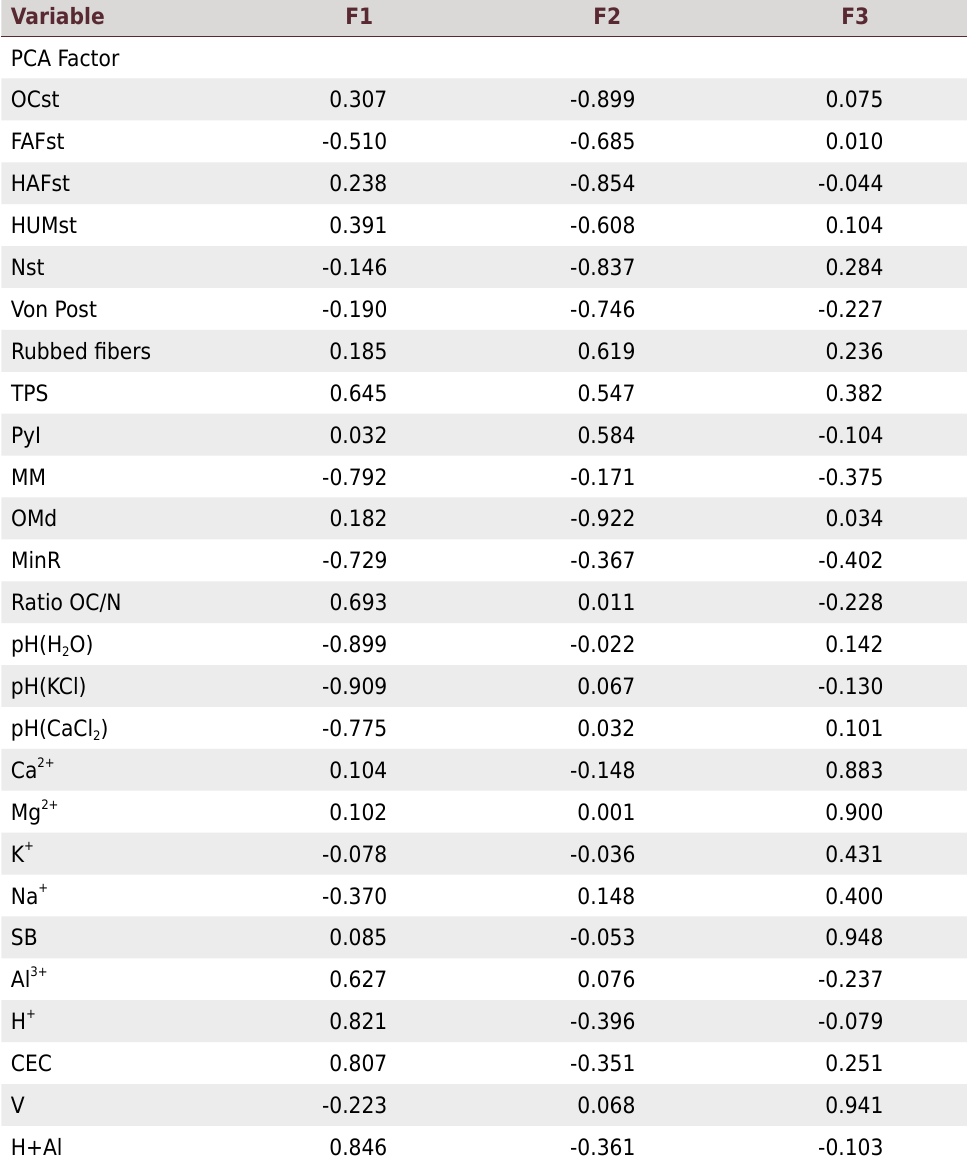
Table 6. Factors estimated by PCA for Organosols based on the matrix of soils properties